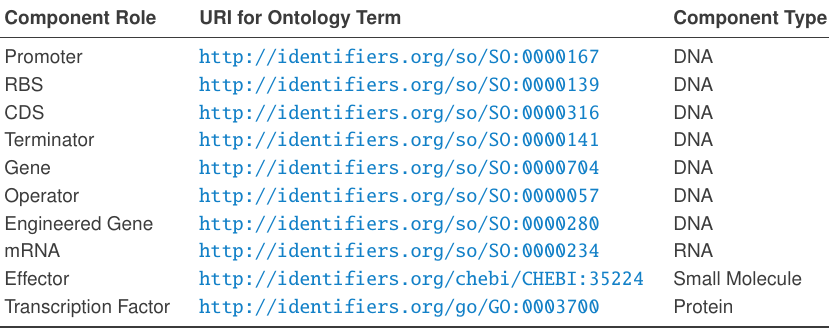
Table 4: Partial list of ontology terms to specify the role property of a Component , organized by the type of Component to which they are intended to apply (see Table